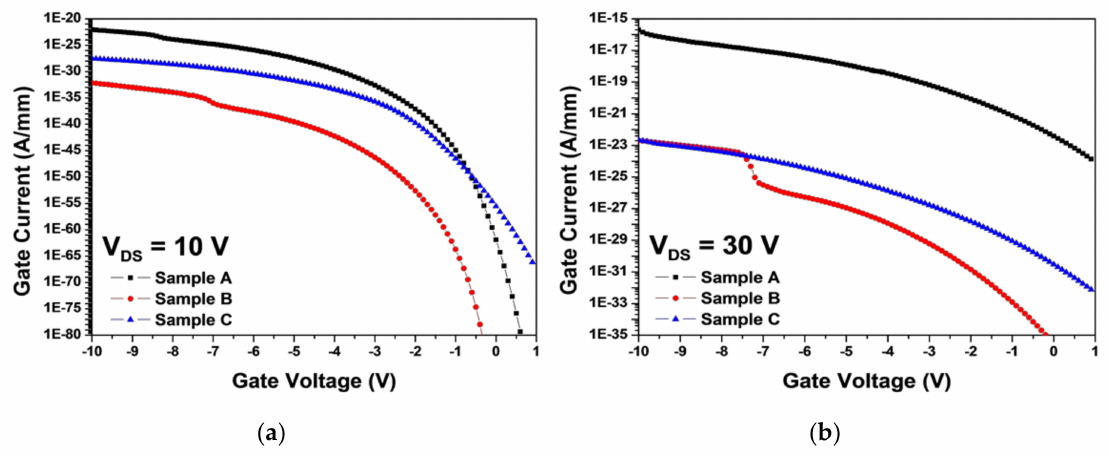
Figure 9. Gate leakage current for MIS-HEMTs (samples A, B, and C) with respect to V GS at ( a ) V DS = 10 V and ( b ) V DS = 30